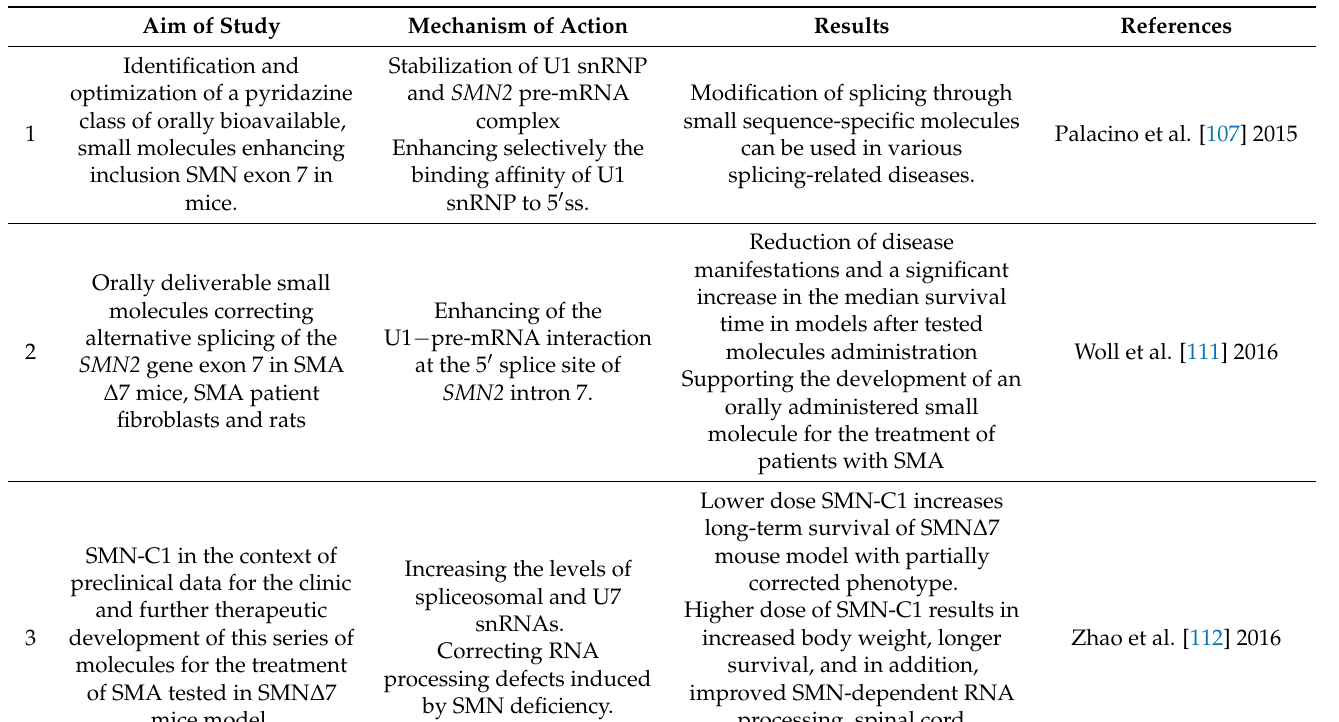
Table 2. Comparison of potential and the newest targets for small molecules in SMA